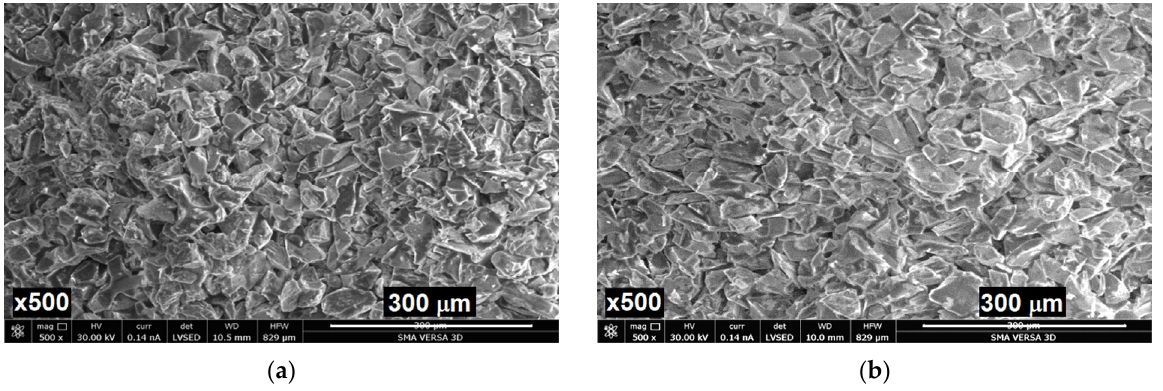
Figure 4. SEM images of fracture surfaces of ceramics based on electrocorundum F240 with 15 wt.% of bentonite binder pressed at ( a ) 30 and ( b ) 40